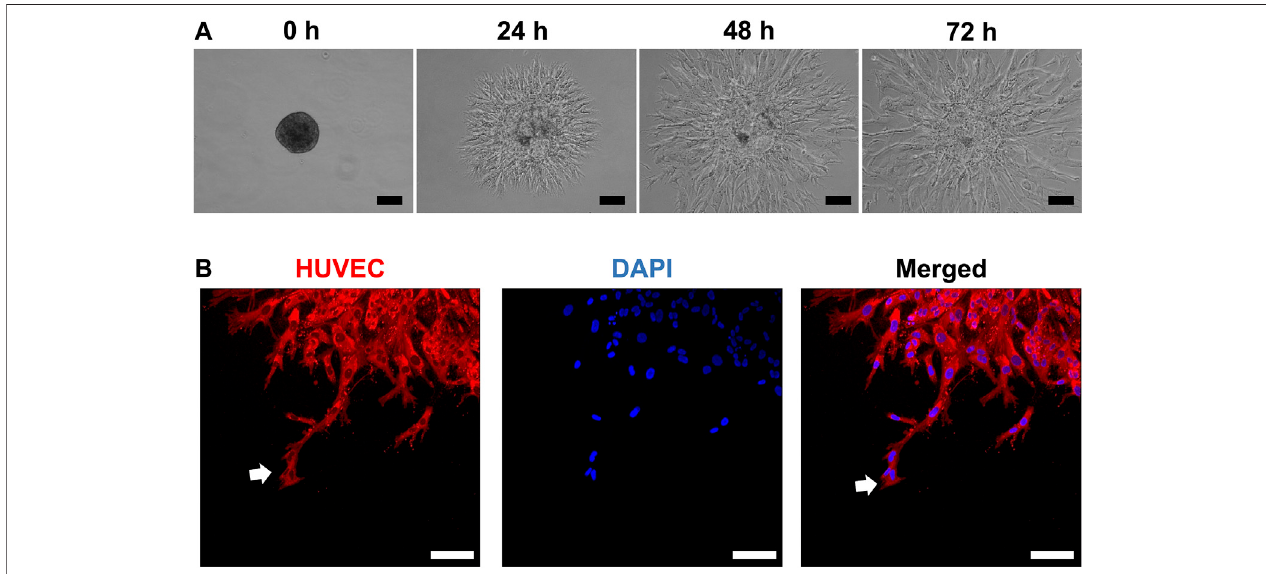
FIGURE 2 | HUVEC sprouting in HPLG. (A) Representative phase-contrast images showing the progression of sprout formation in xeno-free HUVEC spheroids in HPLG; scalebars 100 µm. (B) Representativeconfocalimages showingsproutformationbyHUVECmonoculturespheroidsinunmodi fi edHPLG;initiationbysprouting by “ tip cells ” (white arrows) after 24 h; scale bars 100